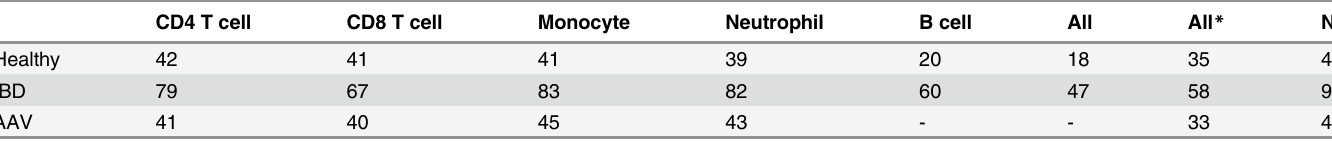
Number of individuals with expression and genotype data available following quality control, by disease and cell type. Column ‘ All ’ indicates the